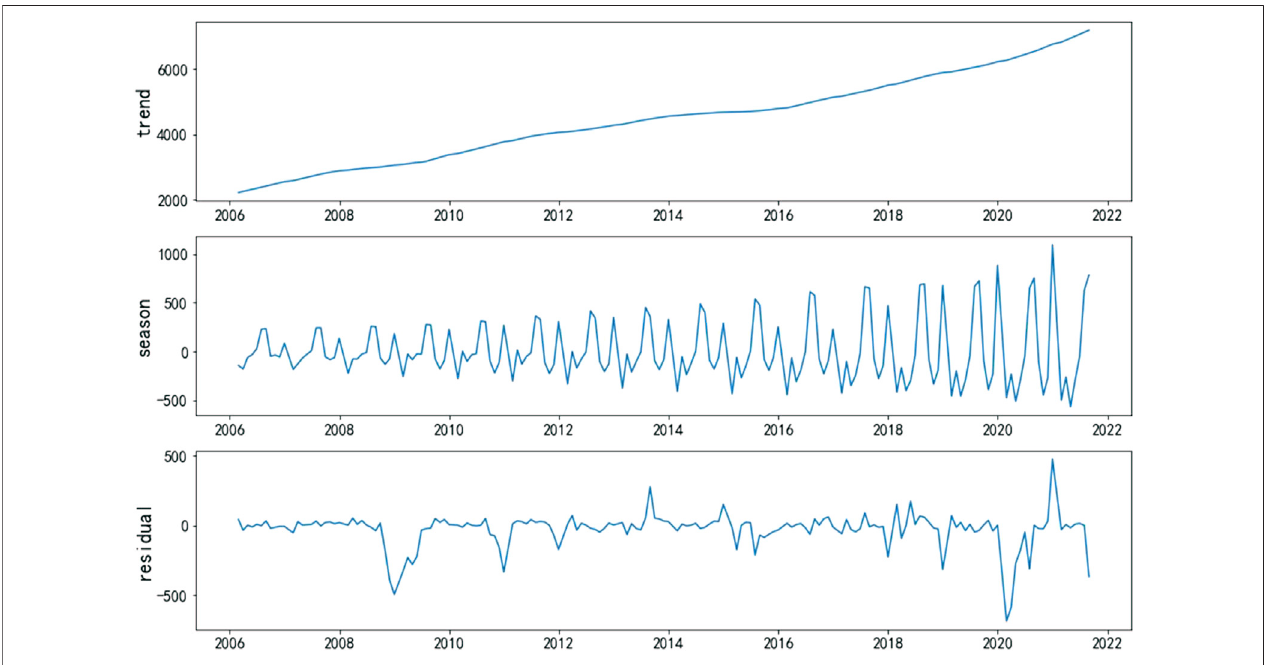
FIGURE 4 | The trend, seasonal, and residual for monthly electricity consumption data decomposed by Seasonal – Trend decomposition using Loess (STL).